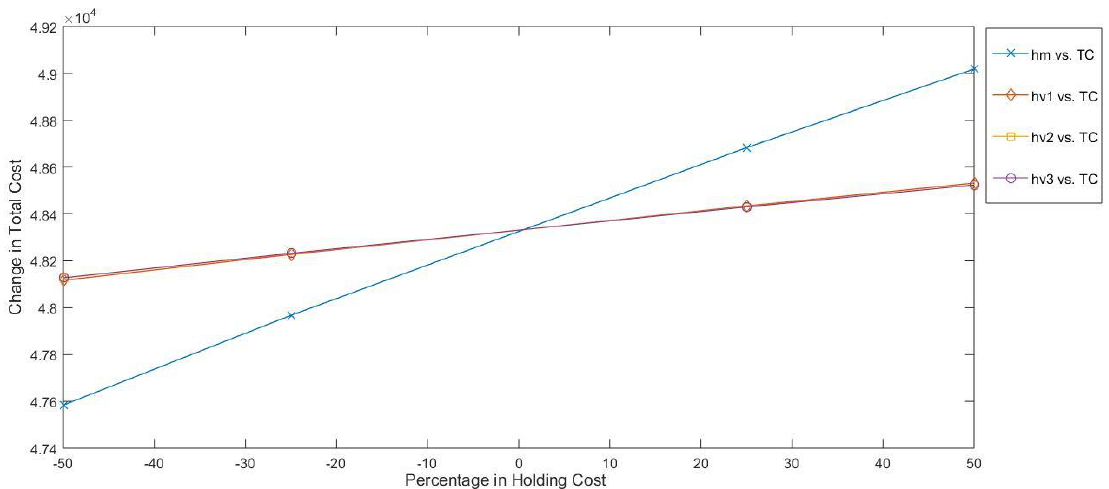
Figure A2. Sensitivity analysis graph for carbon emission and total cost.